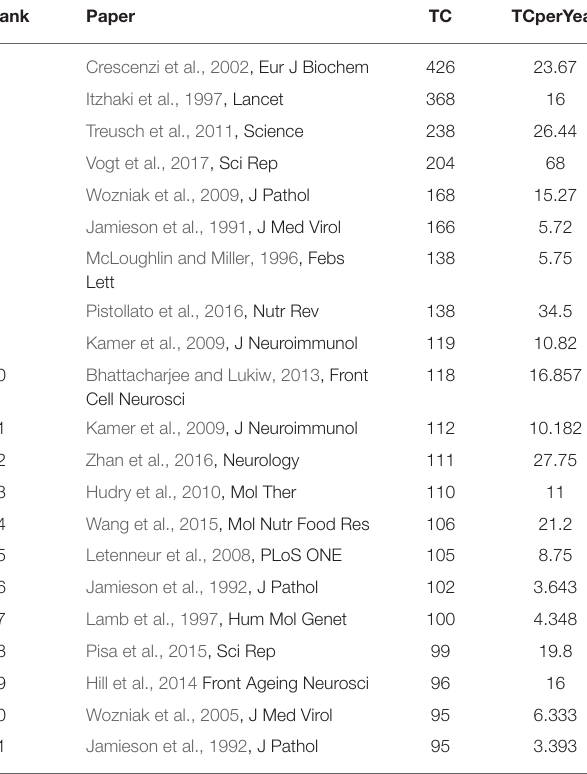
TABLE 2 | Most productive authors on MPP-AD related research from 1982 to 2019.